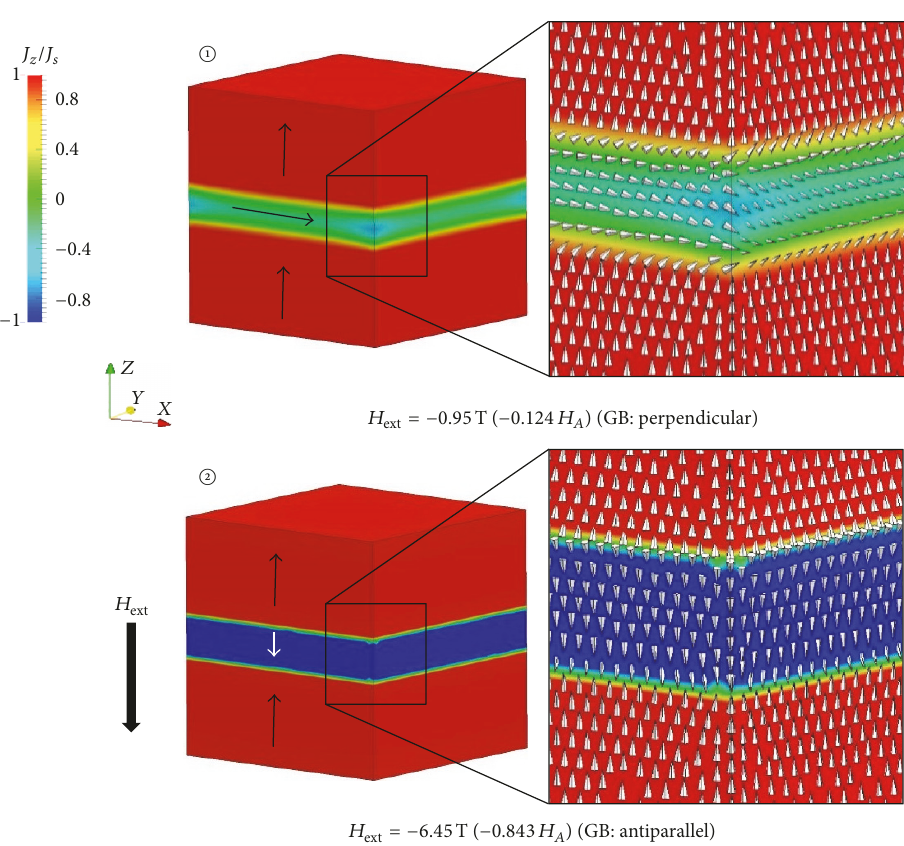
Figure 17: Calculated magnetization states of the 𝑥 -GB with 𝐻 ext // [001] : A the magnetization of the GB is in plane and B the magnetization of the GB is parallel to the external field and antiparallel to the adjacent grains forming two N ´ eel DWs close to the grain